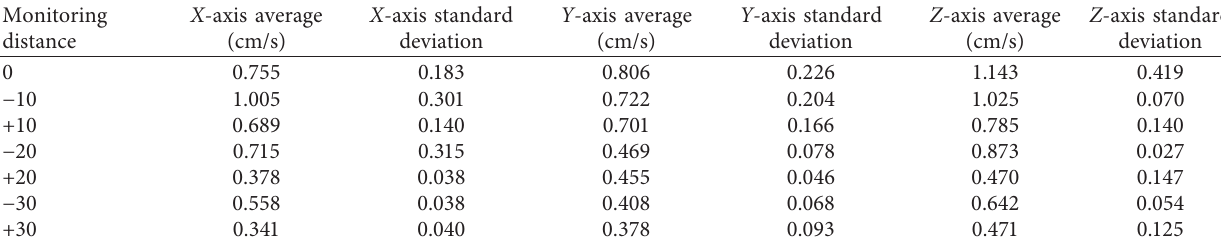
Table 2: Averages and standard deviations of